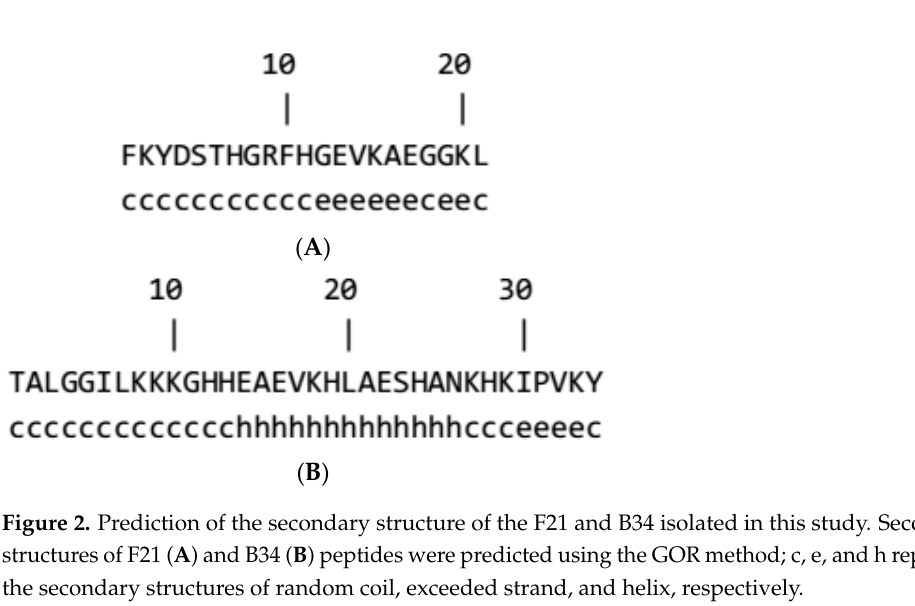
Table 1. Antimicrobial spectra of the hydrolysates F21 and B34. Indicator Strain